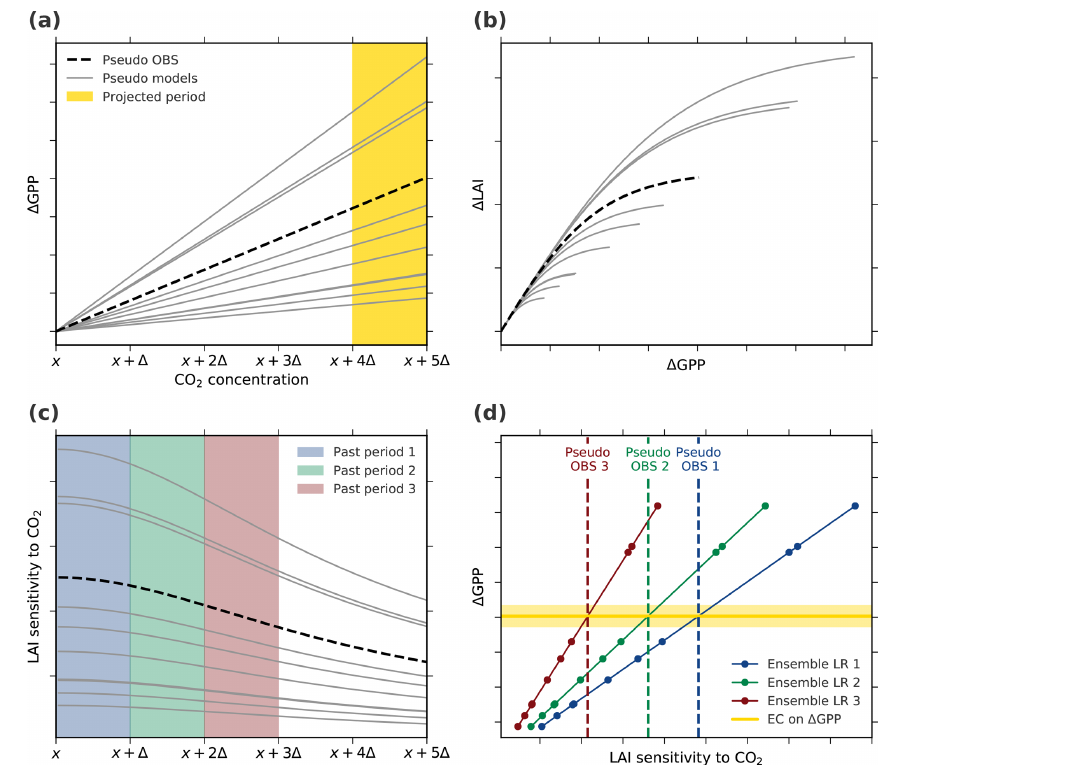
Figure 6. Thought experiment to examine the applicability of EC analysis under the assumption of an idealized linear–nonlinear behavior of the system (Case 3, Table A1). (a) Changes in GPP relate linearly to changes in CO 2 concentration. The yellow band marks the projection period of interest, i.e., the period of CO 2 concentration from x + 4 (cid:49) to x + 5 (cid:49) . (b) The increment in LAI with increasing GPP is assumed to decrease with rising CO 2 concentration (described by a hyperbolic tangent function). The parameterization in the linear and nonlinear functions for pseudo observations (dashed black line) as well as models (solid gray lines) is determined randomly for each model. (c) The diagnostic variable, LAI sensitivity to CO 2 , decreases with increasing CO 2 as a consequence of the nonlinear relation between (cid:49) GPP and (cid:49) LAI. The colored bands indicate three “past” periods from x to x + (cid:49) (blue), x + (cid:49) to x + 2 (cid:49) (green), and x + 2 (cid:49) to x + 3 (cid:49) (red). (d) Linear relationships among the pseudo model ensembles (Ensemble LR, colored lines) between LAI sensitivities to CO 2 of the three past periods and (cid:49) GPP from the projected period. Colored dots mark different models and the dashed lines represent associated pseudo observations for the respective historical period. The solid yellow line depicts the constant EC on projected (cid:49) GPP irrespective of the past period.